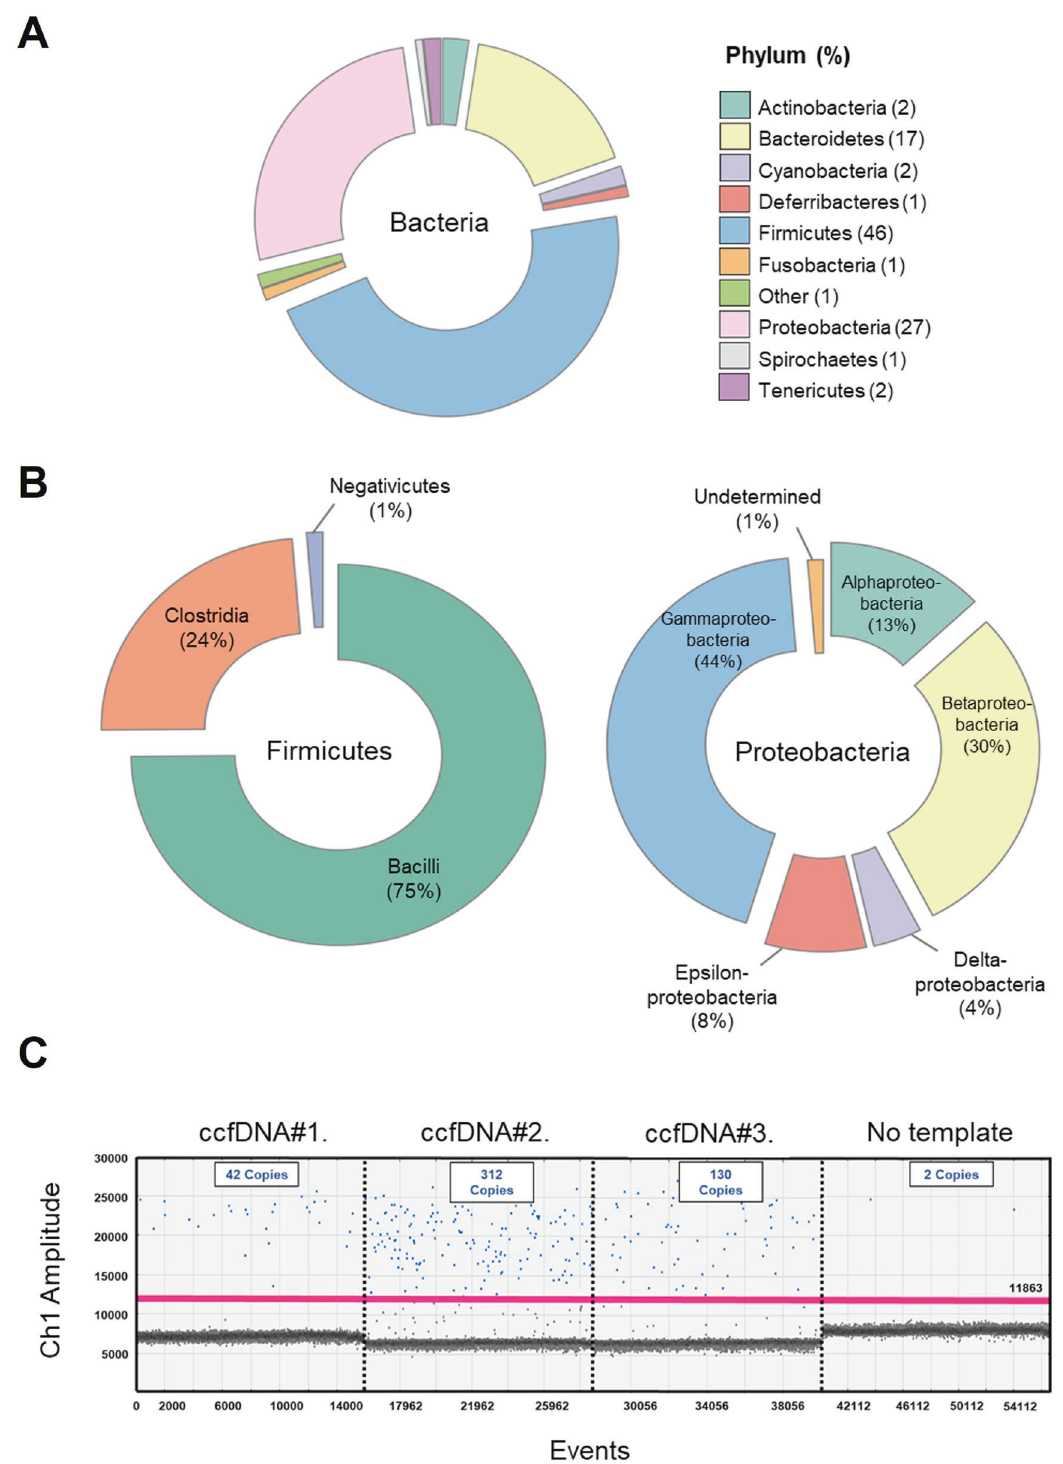
Fig. 4 ccfDNA of bacterial origin. A Relative abundance at the phylum-level. B Microbial diversity of the two top phyla (Firmicutes and Proteobacteria). C Representative ddPCR ampli fi cation of Vibrio spp. 16S rRNA gene fragment (blue color) in three hemolymphs of A. atra and RefSeq libraries (genomes and proteins). Our results showed Detection of metazoan-derived nonself ccfDNA sequences that metazoan nonself ccfDNA fragments were dominated by We fi nally examined whether we could fi nd DNA fragments DNA from bony fi sh (Fig. 5). DNA fragments from insects and other originating from other metazoans. A total of 482 nonself contigs species were also found. A relatively large percentage of DNA were identi fi ed using BLASTN and BLASTX performed with nt, nr